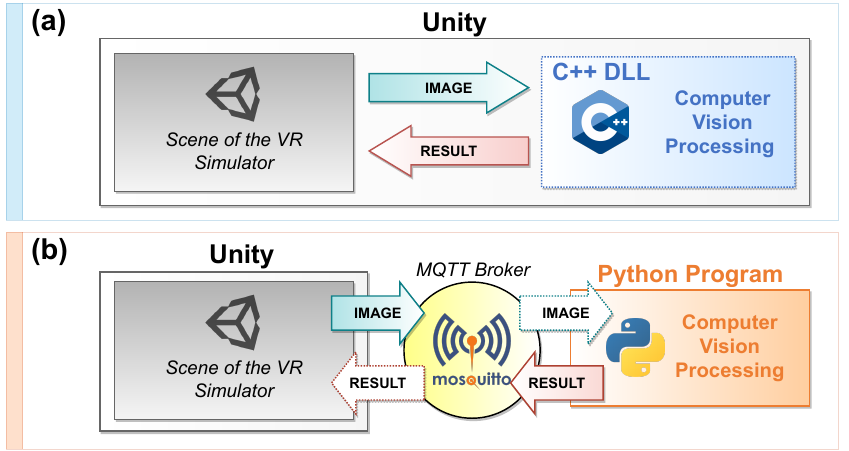
Figure 1. Video processing in Unity using ( a ) a native C++ DLL, ( b ) an external Python module communicated via MQTT.